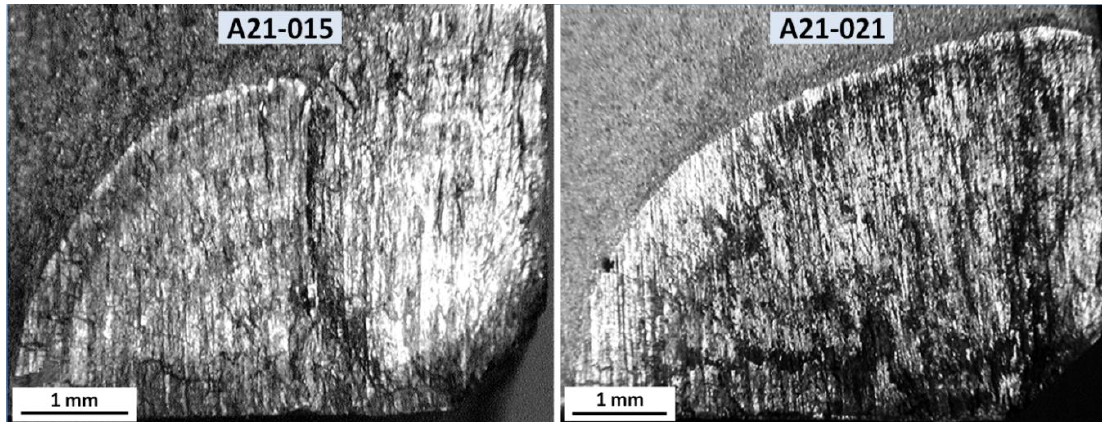
Figure 13. Optical fractographs of fatigue cracks nucleating from corrosion pits in AA7050-T73652 TEF hinge lugs. These were from two different aircraft having tail numbers A21-015 and A21-021, respectively. Reprinted with permission from [46]. Copyright 1994 DST.